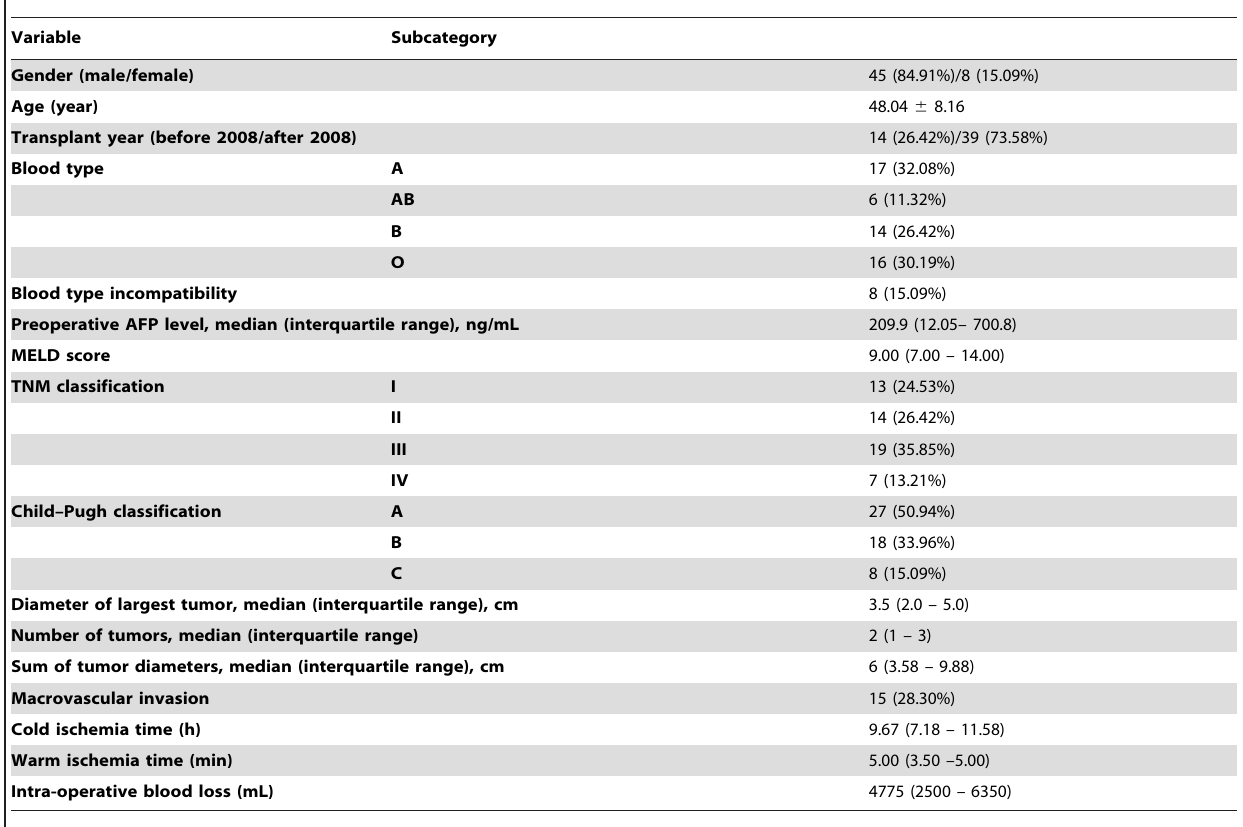
Table 1. Clinical profiles of all the recipients who underwent SLT.